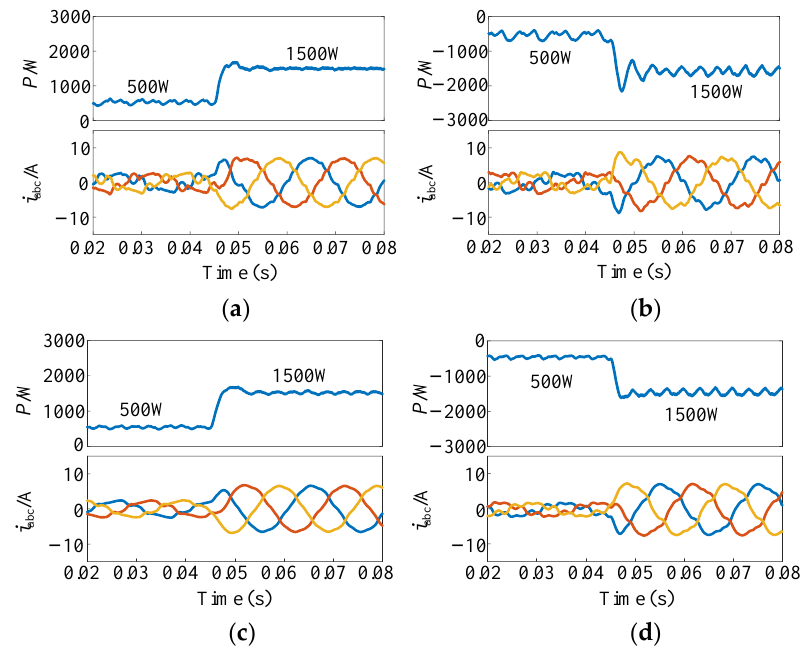
Figure 14. Simulation results at the low-power level as P changes, with U d = 155 V. ( a ) Conventional control under forward power flow. ( b ) Conventional control under reverse power flow. ( c ) IRSE control under forward power flow. ( d ) IRSE control under reverse power flow.